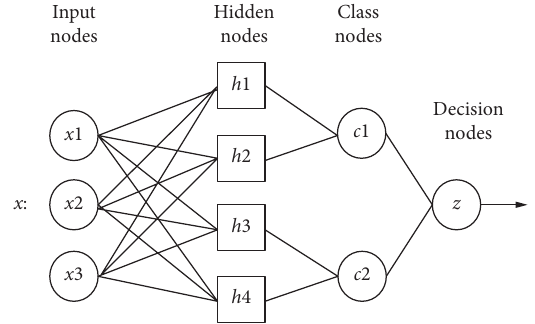
Figure 3: GRNN architecture [46].